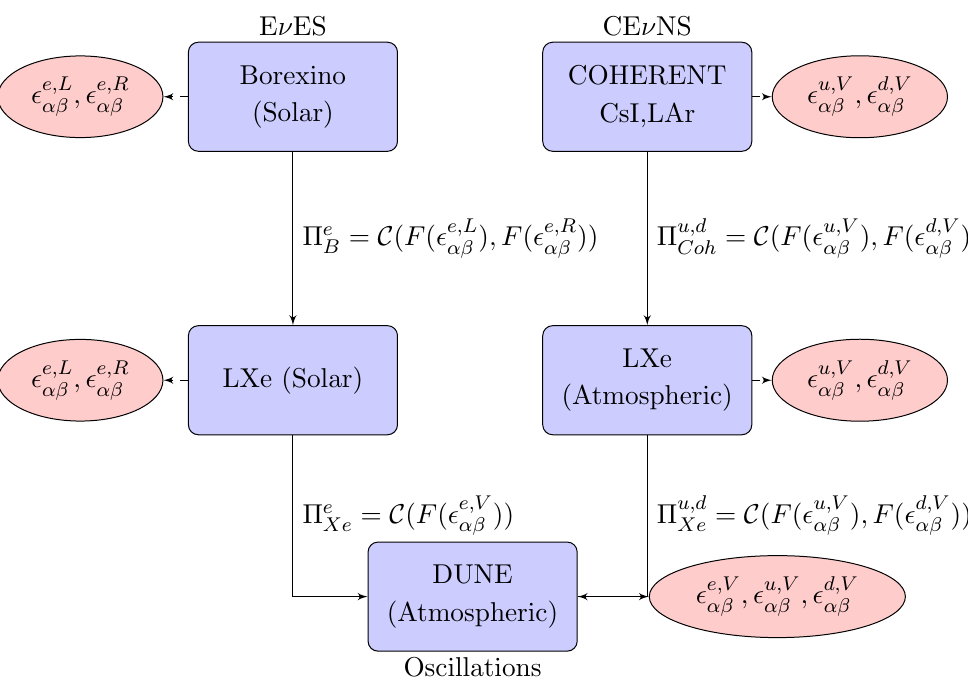
Figure 3 . The \Prior-Flow" of joint probability information from experiment to experiment. We begin with E (cid:23) ES from solar neutrinos at Borexino and CE (cid:23) NS at COHERENT, then proceed to E (cid:23) ES and CE (cid:23) ES scattering at a future 1 kton year LXe dark matter detector, and (cid:12)nally to future (cid:1) atmospheric neutrino oscillation measurements at DUNE. The components of each prior that are inherited from a previous experiment are denoted by (cid:5), which are taken as empirical copulas of the relevant marginals of the NSI parameters. If one of the previous experiments is not sensitive to a particular NSI, the uniform distribution is taken as a prior for that corresponding